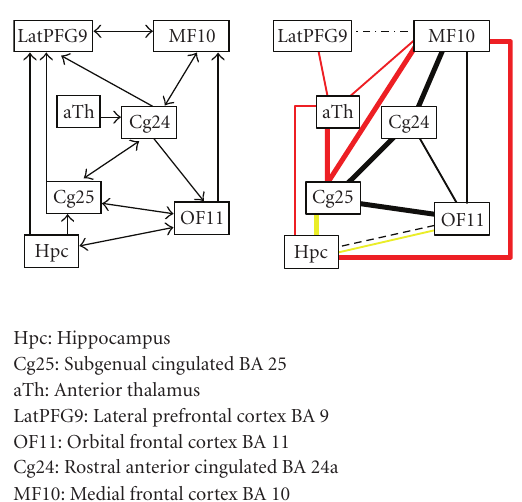
Figure 7: The network and results for Seminowicz et al. BA = Brodmann